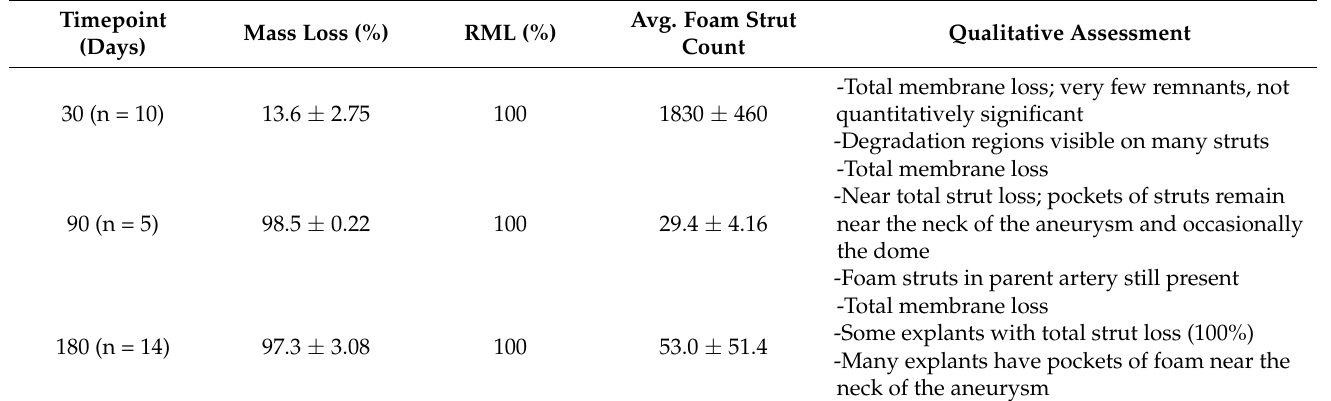
Table 7. NED degradation quantification/qualification in a rabbit elastase aneurysm